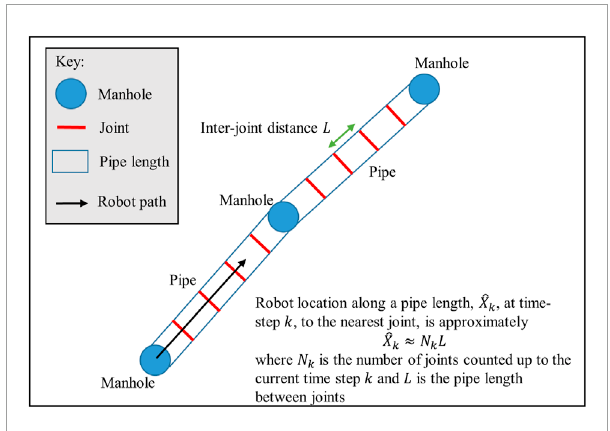
FIGURE 2 Diagram demonstrating how joint detection can be used to calculate the approximate robot location along the pipe length. The focus of this paper is on developing a robust vision-based method for detecting pipe joints from camera images to determine the joint count N k